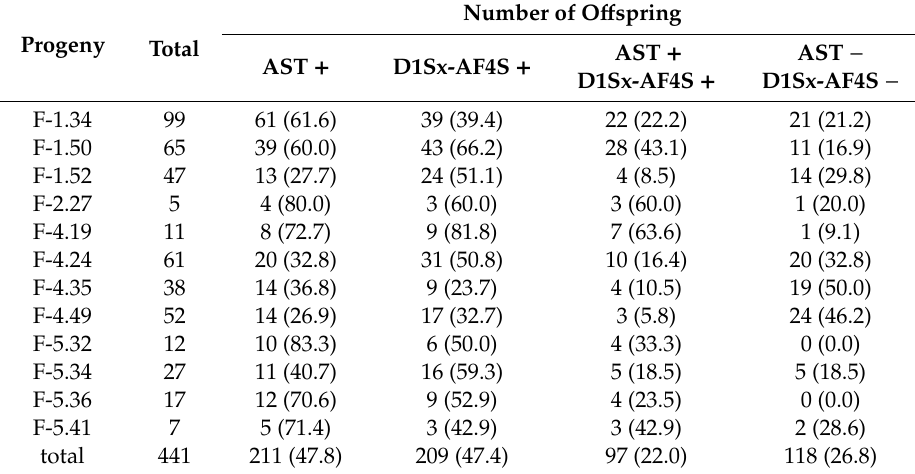
Table 2. Results of genotypes analyzed by molecular markers. Number of o ff spring with the astringent allele (AST), with the DlSx-AF4S allele, with AST + DlSx-AF4S (not selected) and number of o ff spring with the absence of both markers (genotypes